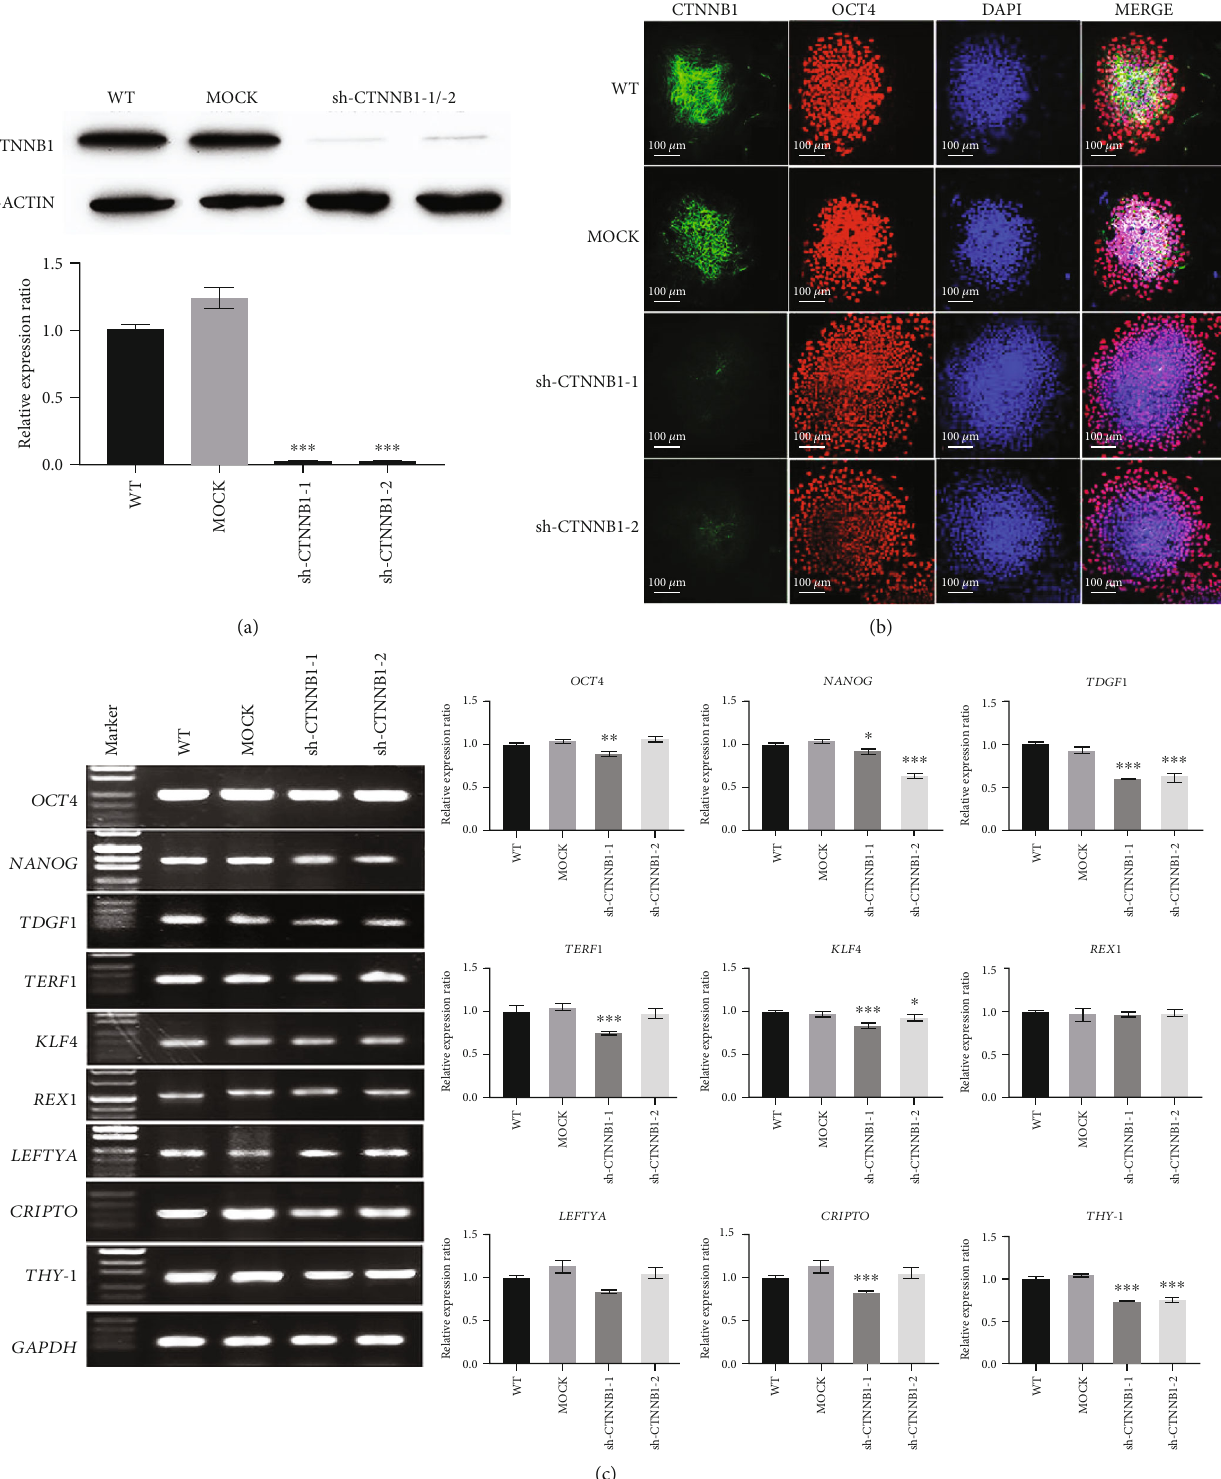
Figure 2: shRNA induces the downregulation of CTNNB1 expression in hESCs. (a) Western blot analysis of CTNNB1 protein in the shCTNNB1 group, empty vector group (MOCK), and uninfected control group (WT) hESCs. (b) Immuno fl uorescence assay of CTNNB1 and OCT4 in shRNAs, MOCK, and WT hESCs ( scale bar = 100 μ m ). (c) Semiquantitative RT-PCR validation of mRNA expression levels of pluripotency genes in shCTNNB1, MOCK, and WT hESCs. Error bars denote mean ± SD from three independent experiments ( n = 3 , ∗ p < 0 : 05 , ∗∗ p < 0 : 01 , ∗∗∗ p < 0 : 001 , relative to WT